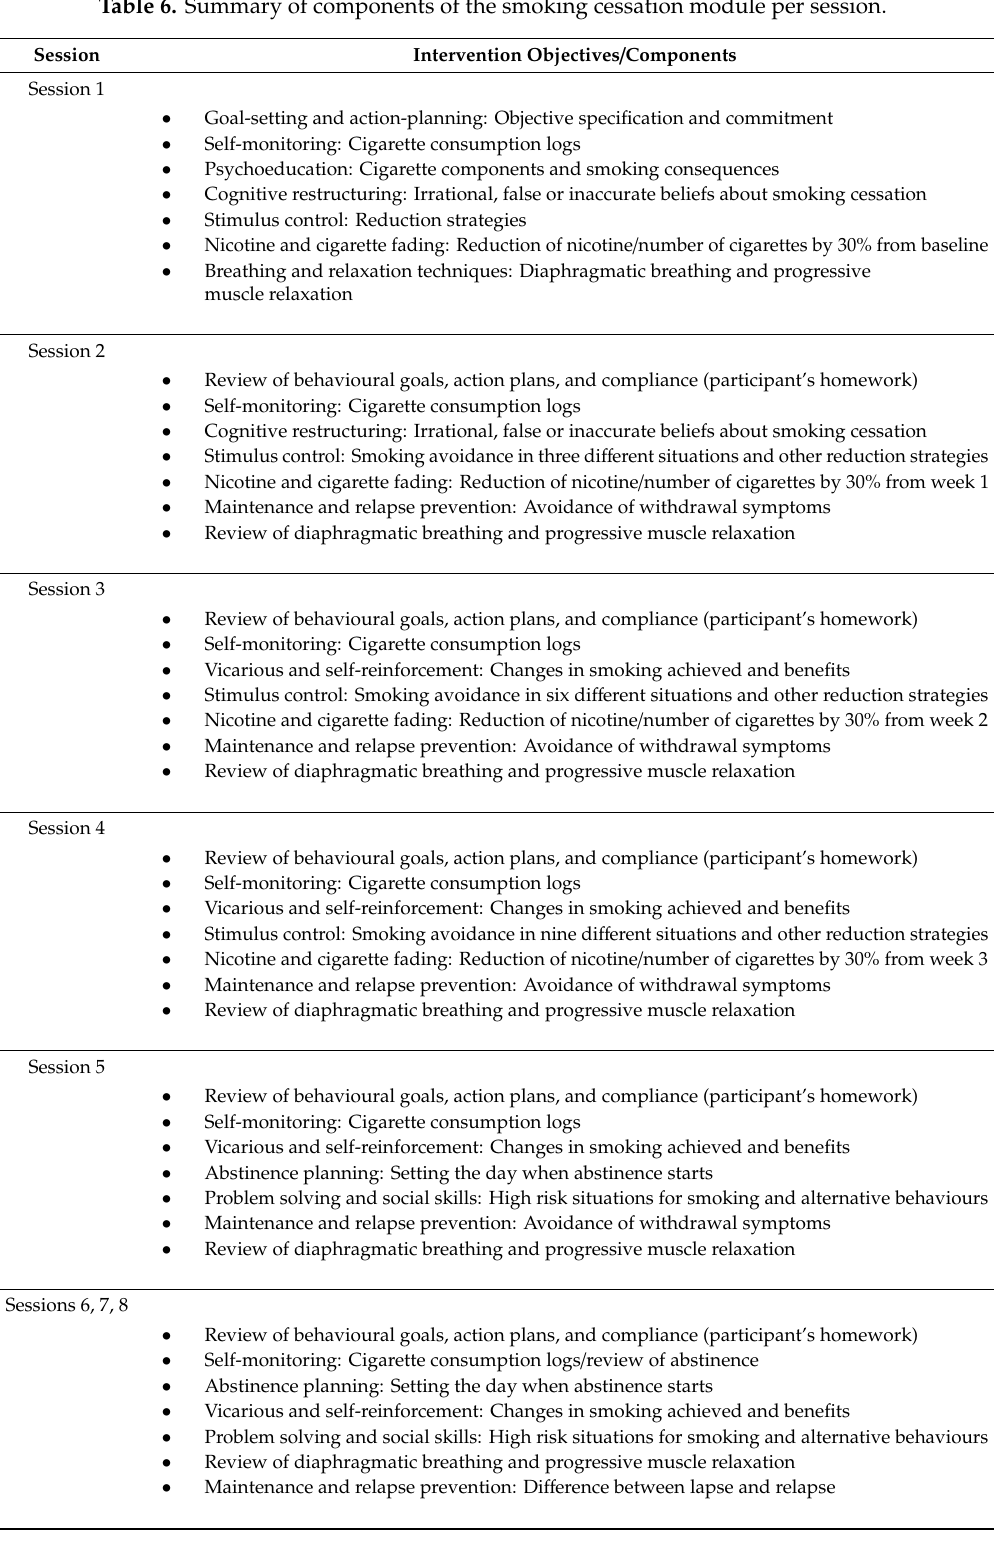
Table 6. Summary of components of the smoking cessation module per